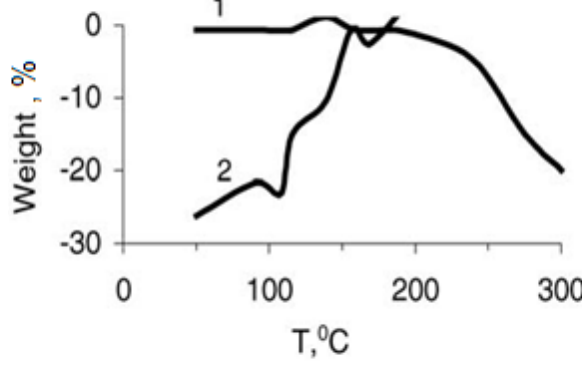
Figure 2. Weight loss (% of the SHMPE) (curve 1) and differential thermal assay (curve 2) via thermo-oxidative destruction of the SHMPE. Heating rate is 3.2 ° C/min